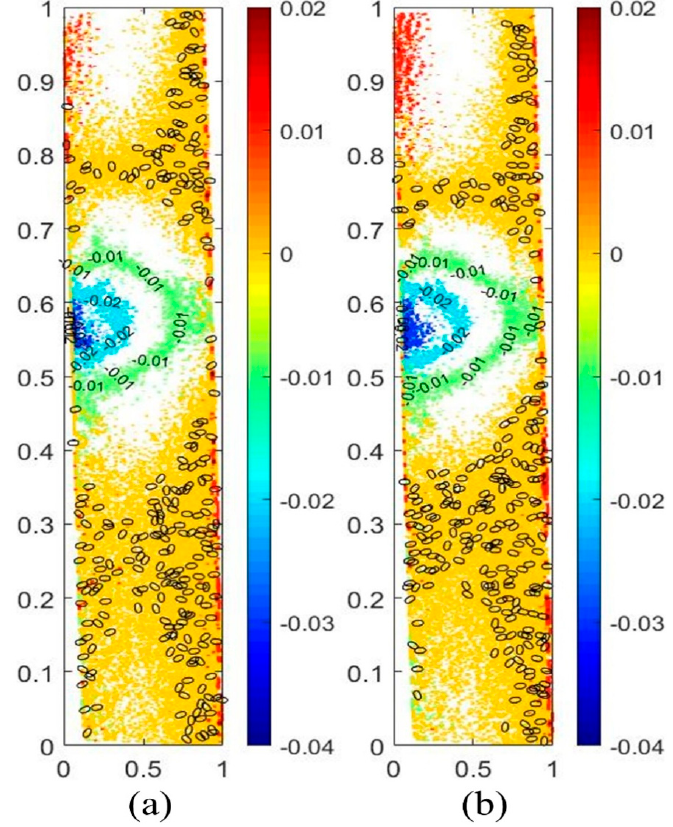
Figure 17. Out-of-plane displacement contour of S2 (unit: cm): ( a ) Δ F = 600 N, ( b ) Δ F = 1000 N.